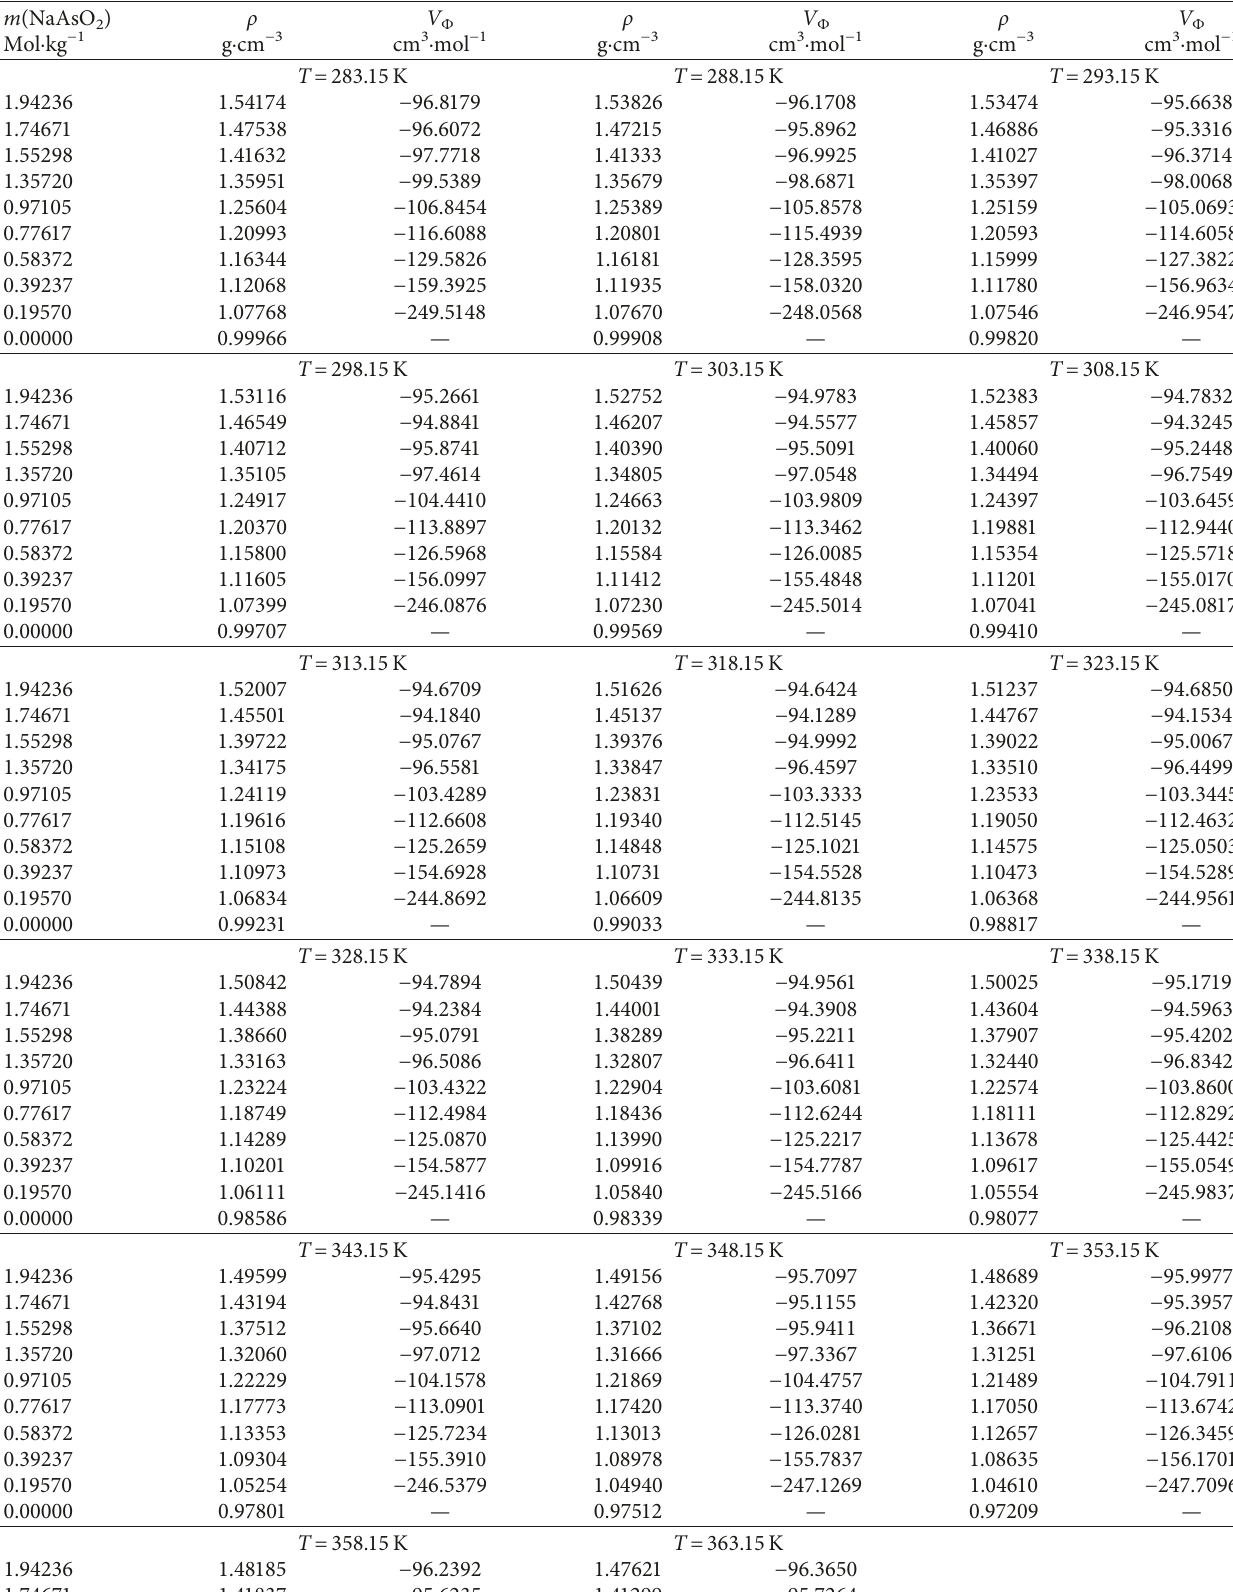
Table 3: Apparent molar volumes and densities of the NaAsO 2 +H 2 O system at various temperatures and molalities at 101 ± 5kPa.